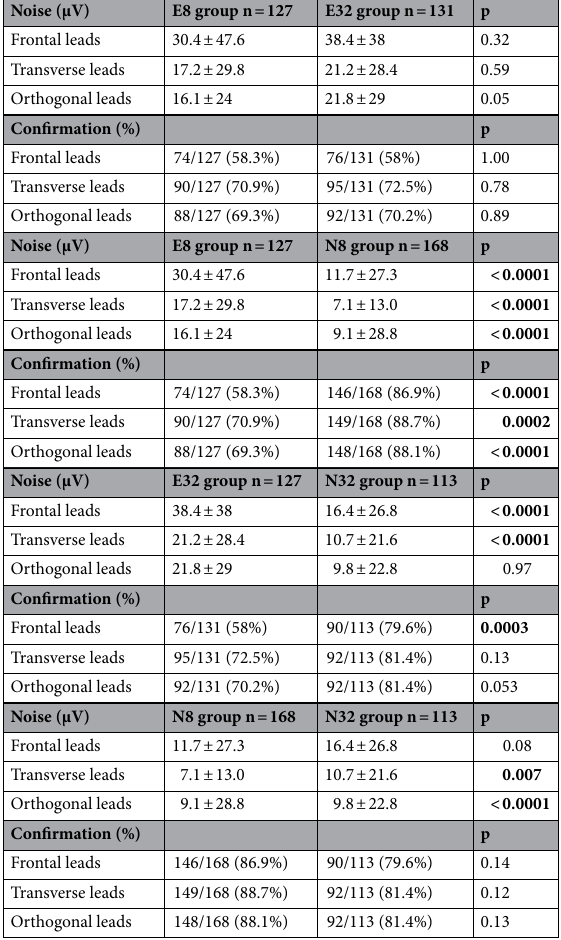
Table 5. Noise values and confirmation during the recovery phase, according to set of leads in the different groups. Noise values are expressed as mean and standard deviation. Groups: E8 = Ellestad factor 1/8; E32 = Ellestad factor 1/32; N8 = Naughton factor 1/8; N32 = Naughton factor 1/32. Data presented as Mean ± Standard Error. Bold values indicate statistical significance. Significant p-value considered 0.0083 (Bonferroni’s